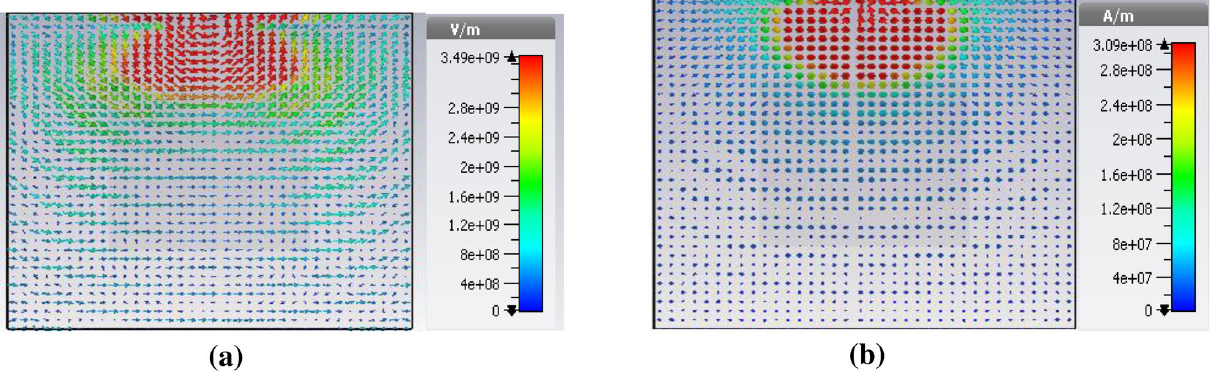
Fig. 6 Field distribution a E field b H